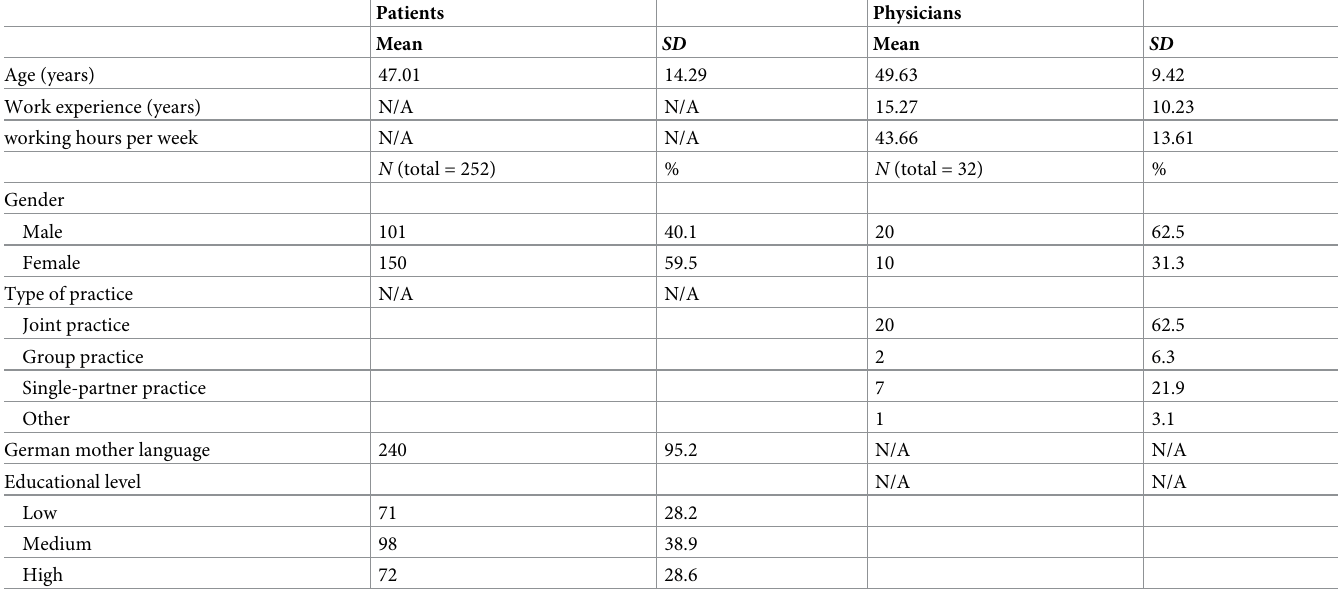
Table 1. Characteristics of patients and physicians included in the